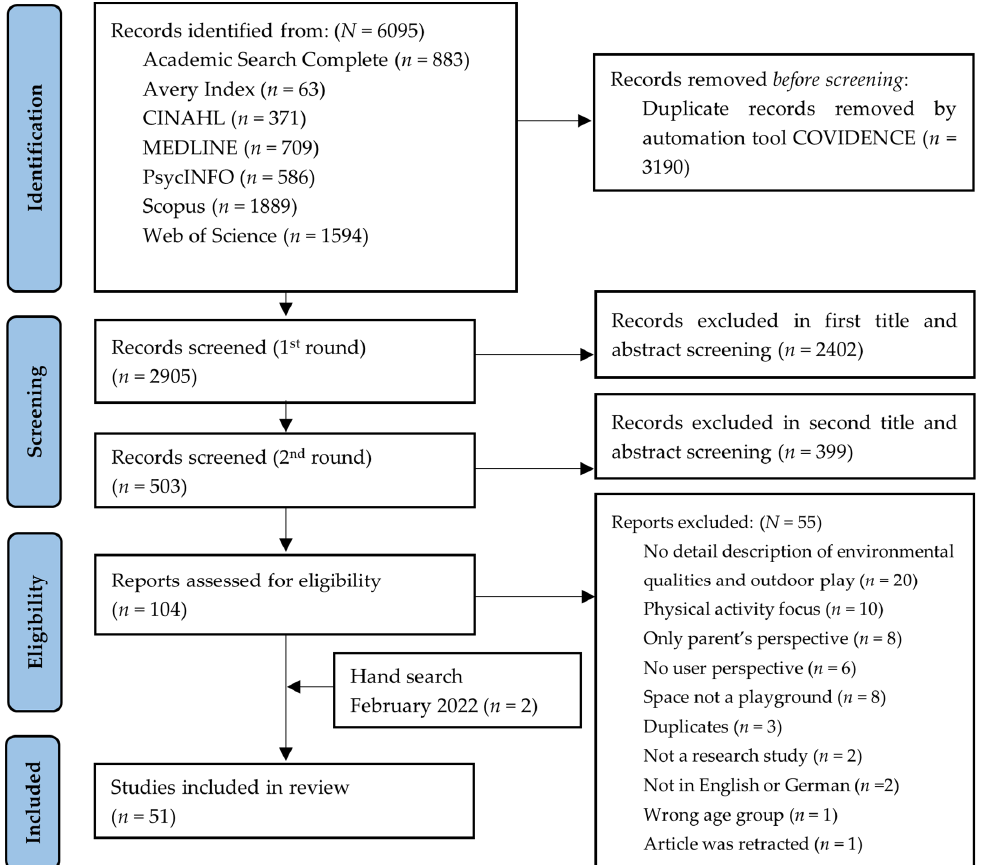
Figure 1. Prisma flowchart identification, screening, eligibility, and inclusion of studies.